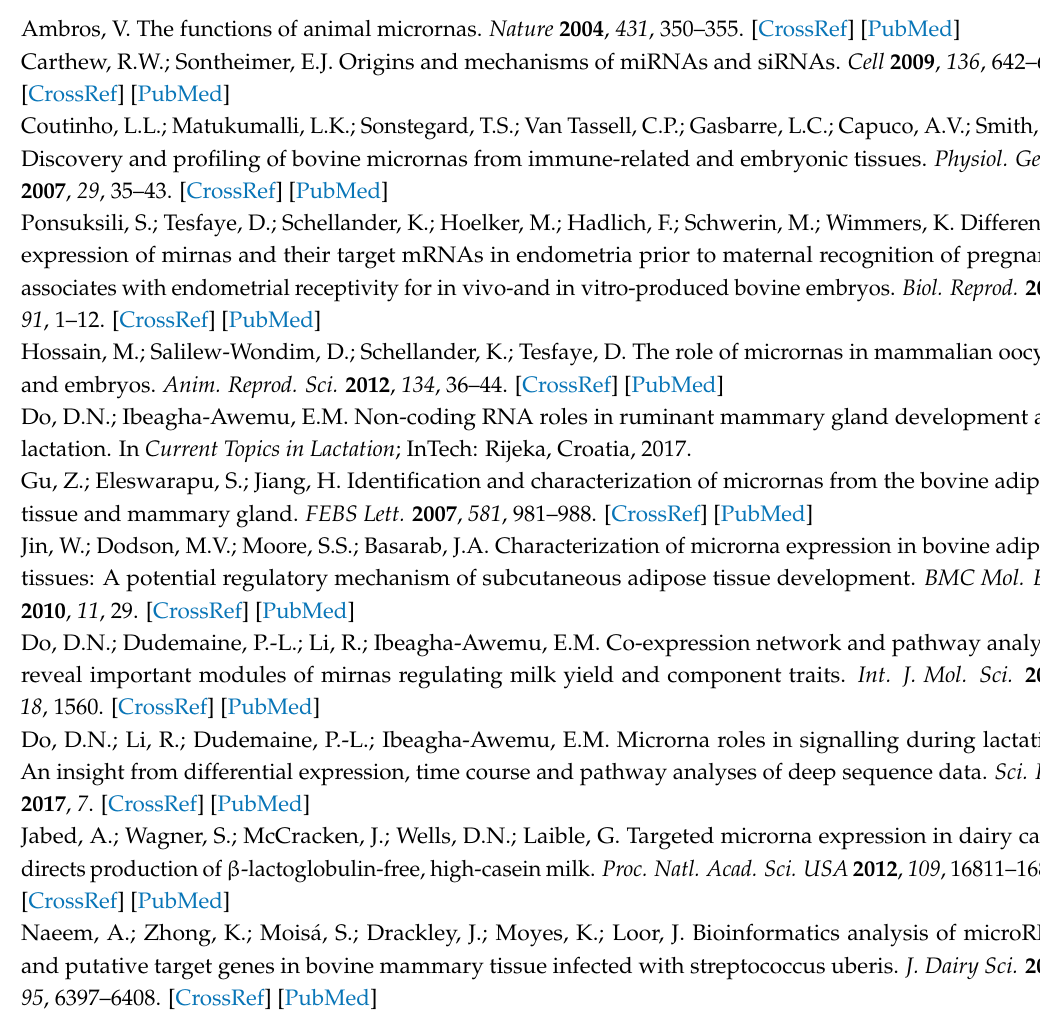
Table S1: Mapping statistics of miRNA sequencing reads; Table S2: Length distribution (nt) of miRNA reads; Table S3: Novel miRNAs identified by miRDeep2; Table S4: Novel and known miRNAs and their read count summary; Table S5; The 20 most highly expressed miRNAs and their predicted target genes (a); enriched gene ontology terms (b) and enriched KEGG pathways (c); Table S6; Differentially expressed miRNAs between day 33 (pre-weaning) and day 96 (post-weaning) (a); predicted target genes of DE miRNAs (b) and differentially expressed genes which are both negatively correlated and predicted targets of miRNAs (c); Table S7; Gene ontology and KEGG pathways enriched for target genes of differential expressed miRNAs; Table S8; Differentially expressed genes that were targets of DE miRNAs and also negatively